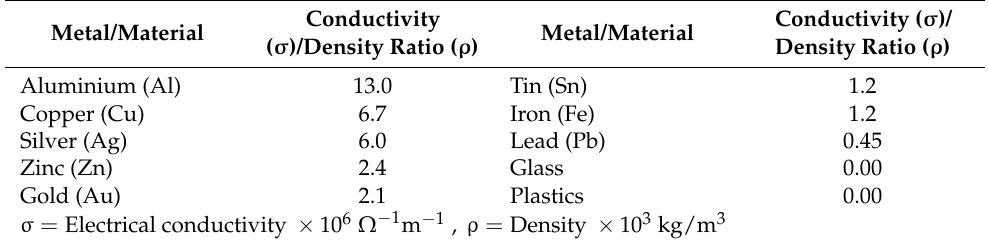
Table 1. Deflection coefficients for metals/materials (Source: Yazici et al.